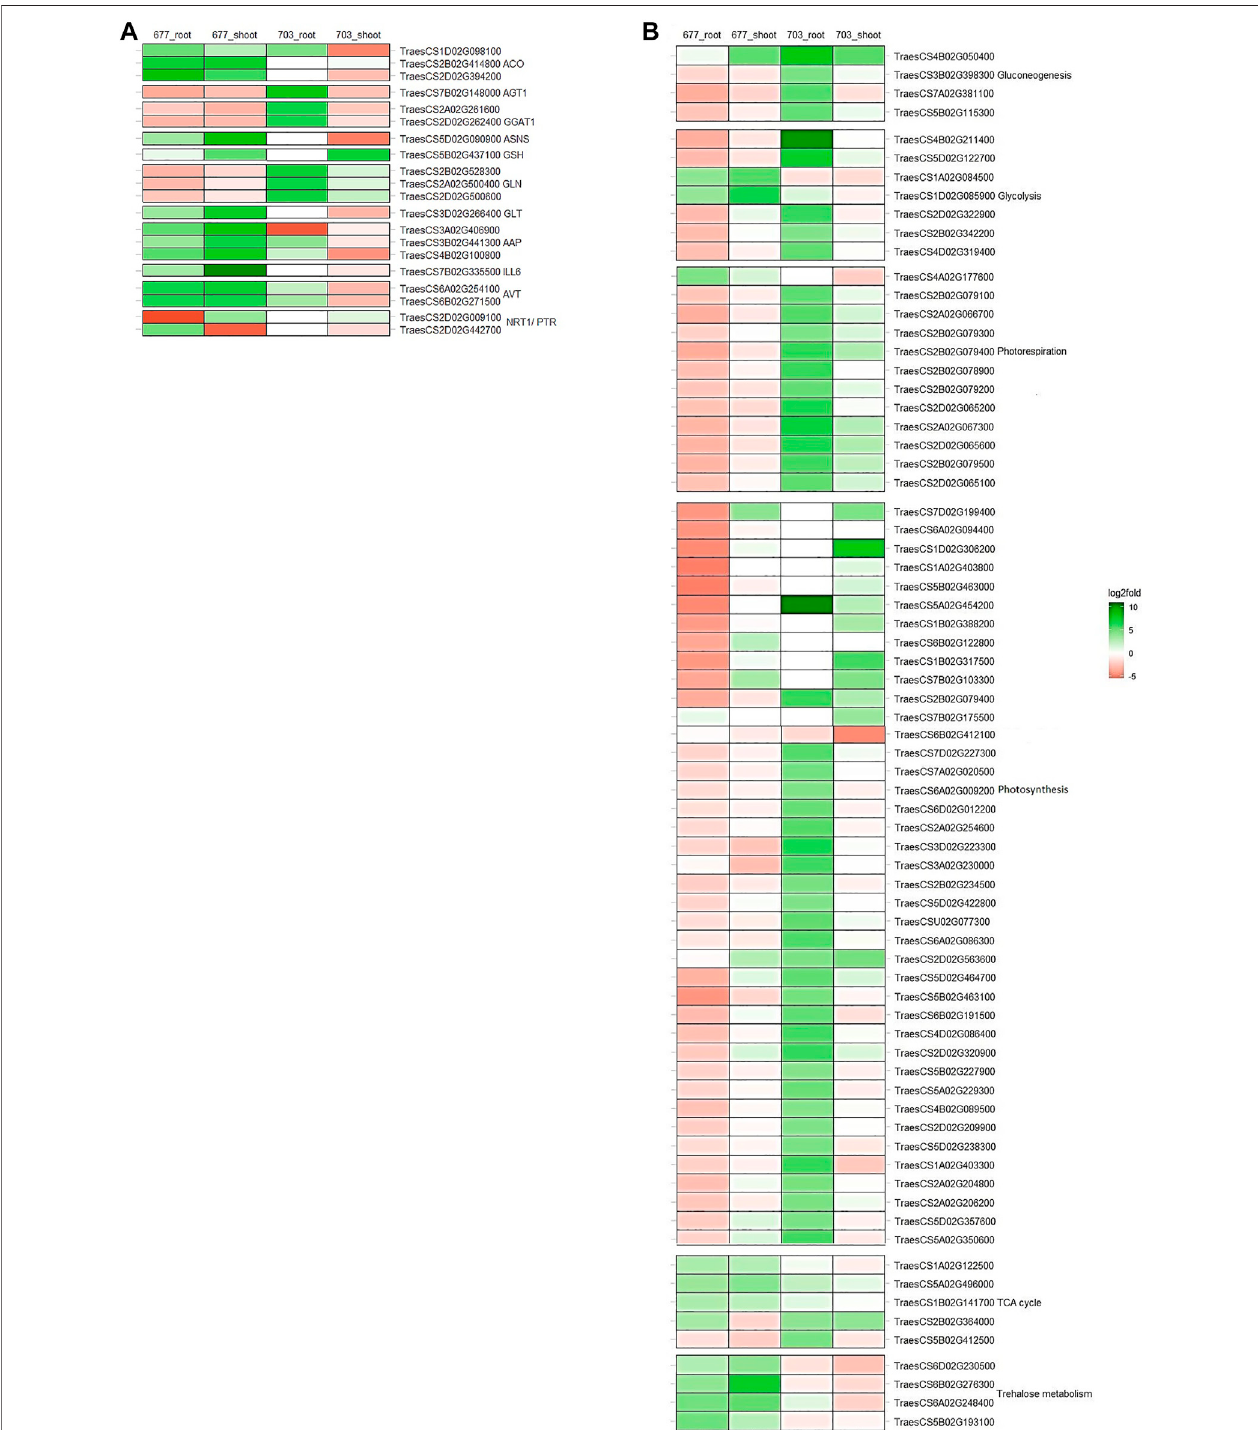
FIGURE 4 | Heatmaps showing the expression patters of genes involved in between tissues and in both genotypes (A) primary nitrogen metabolism (B) carbon metabolism. *Colours indicate the differential gene expression in nitrogen stressed tissue; upregulated: green; downregulated: red; Do not have signi fi cant expression: white.